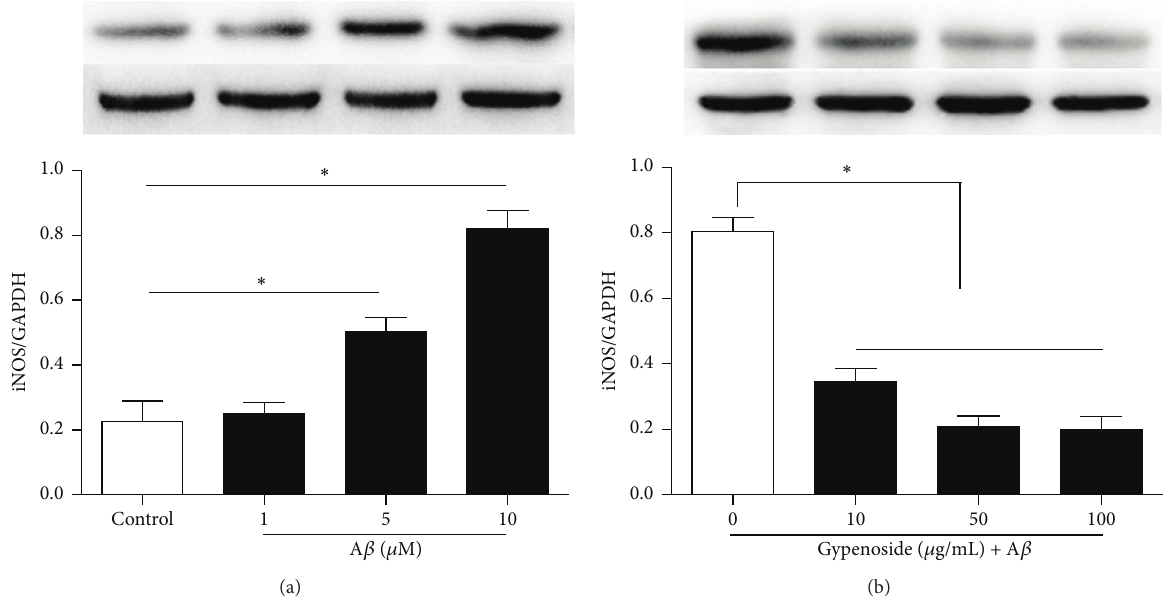
Figure 2: GP attenuated iNOS protein expression in A 𝛽 -stimulated microglial cells in a dose-dependent manner. The microglial cells were exposed to different concentrations of A 𝛽 for 24 h; then the iNOS expression was assessed by using western blot (a). The cells were exposed to different concentrations of GP in the presence of 10 𝜇 M A 𝛽 for 24 h; then the iNOS expression was assessed (b). Data are means ± SD, 𝑛 = 4 , ∗ : 𝑃 < 0.05